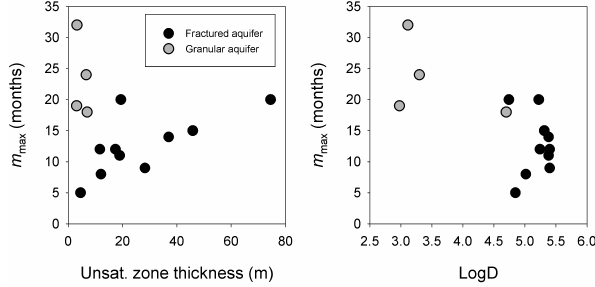
Fig. 13. m max as a function of (a) unsaturated zone thickness and (b) log-hydraulic diffusivity